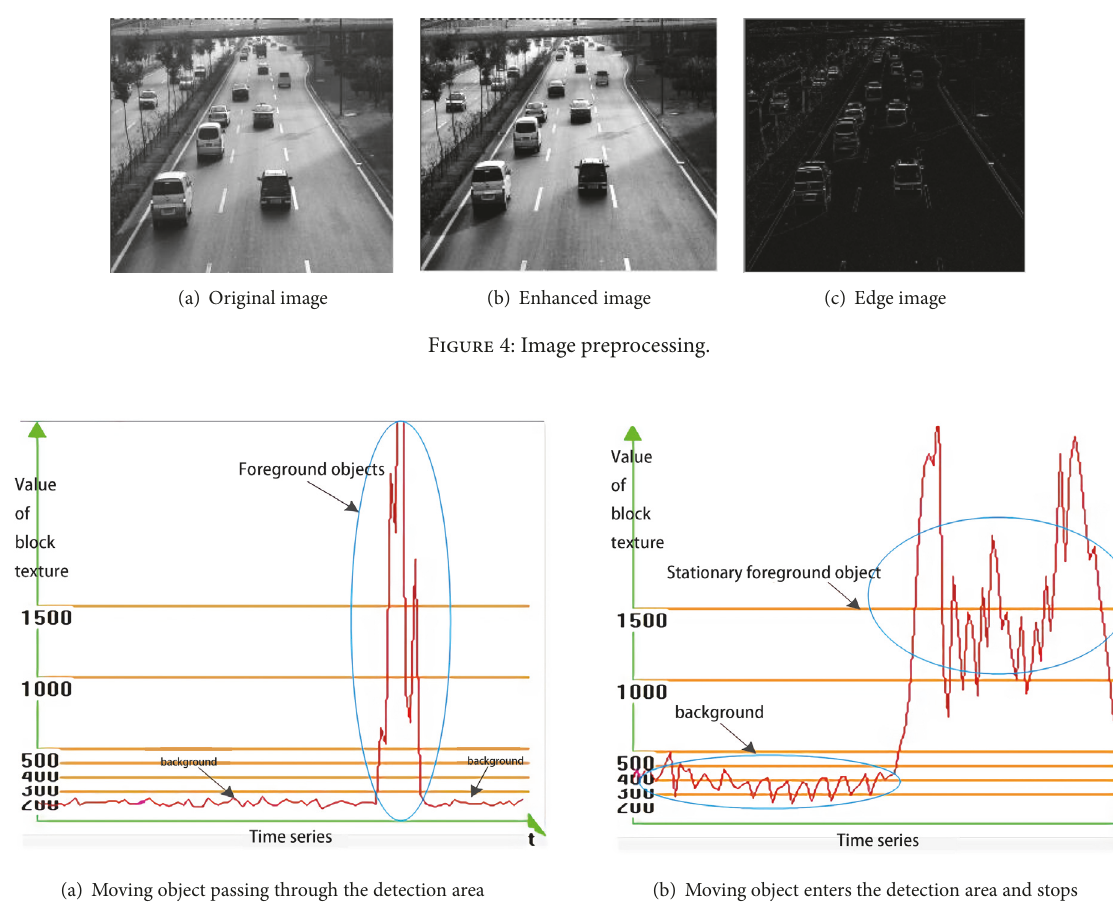
Figure 5: Texture changes of blocks in the detection area.